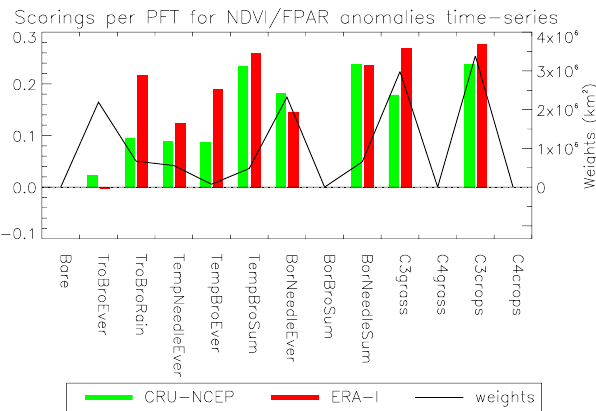
Fig. 8. Surface-weighted median values per PFT, for the anomaly NDVI/FPAR time series correlations. The green bars are for CRU- NCEP meteorological forcing and the red bars for ERA-Interim me- teorological forcing. The black thick line indicates the total surface of the boxes used to assess the PFT median